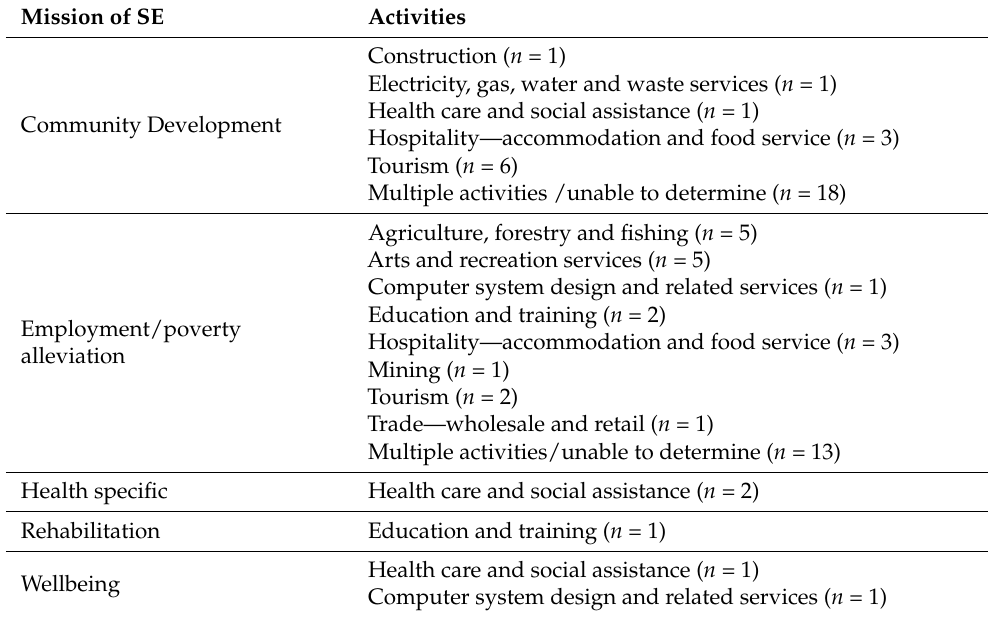
Table A2. Relationship between mission and activities of Indigenous social